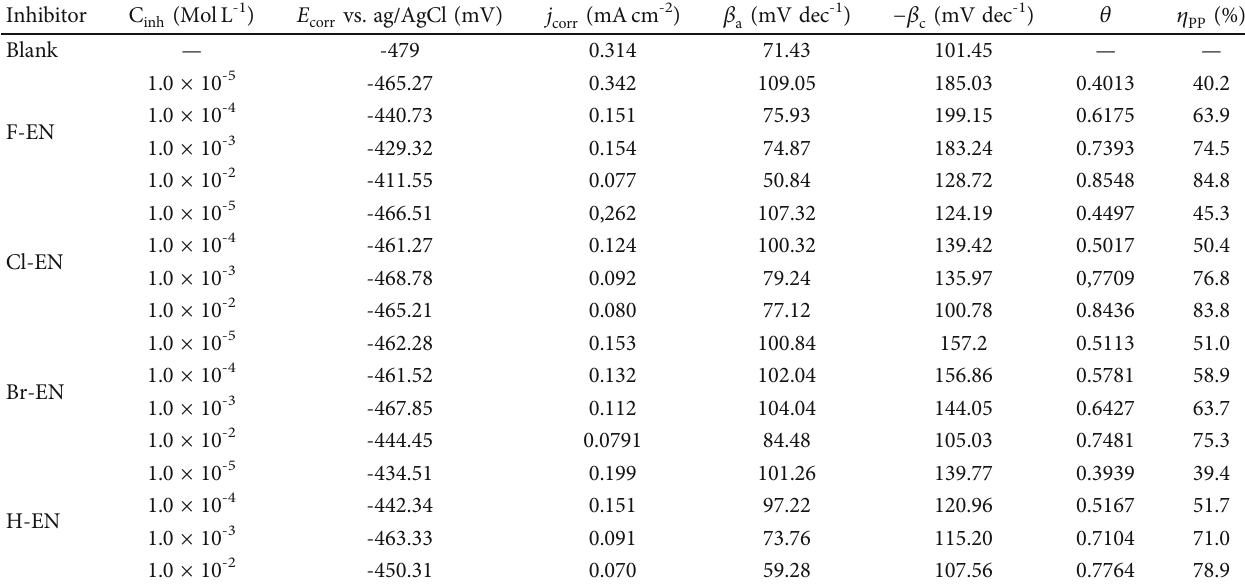
Table 4: Electrochemical parameters obtained by PP tests for enaminoesters in 1.0molL -1 HCl medium in AISI 1020 carbon steel. Inhibitor C inh (MolL -1 )